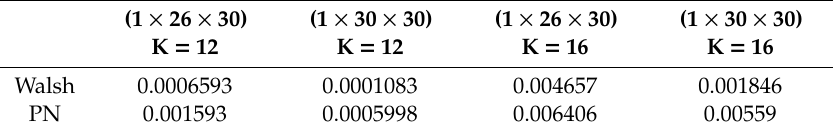
Figure 4. BER vs. SNR for a (1 × 26 × 30) and (1 × 30 × 30) MIMO configurations, QPSK modulation, PN code with 12, 16 active users. Table 2. BER vs. SNR for Walsh and PN spreading codes for SNR = 12 dB.